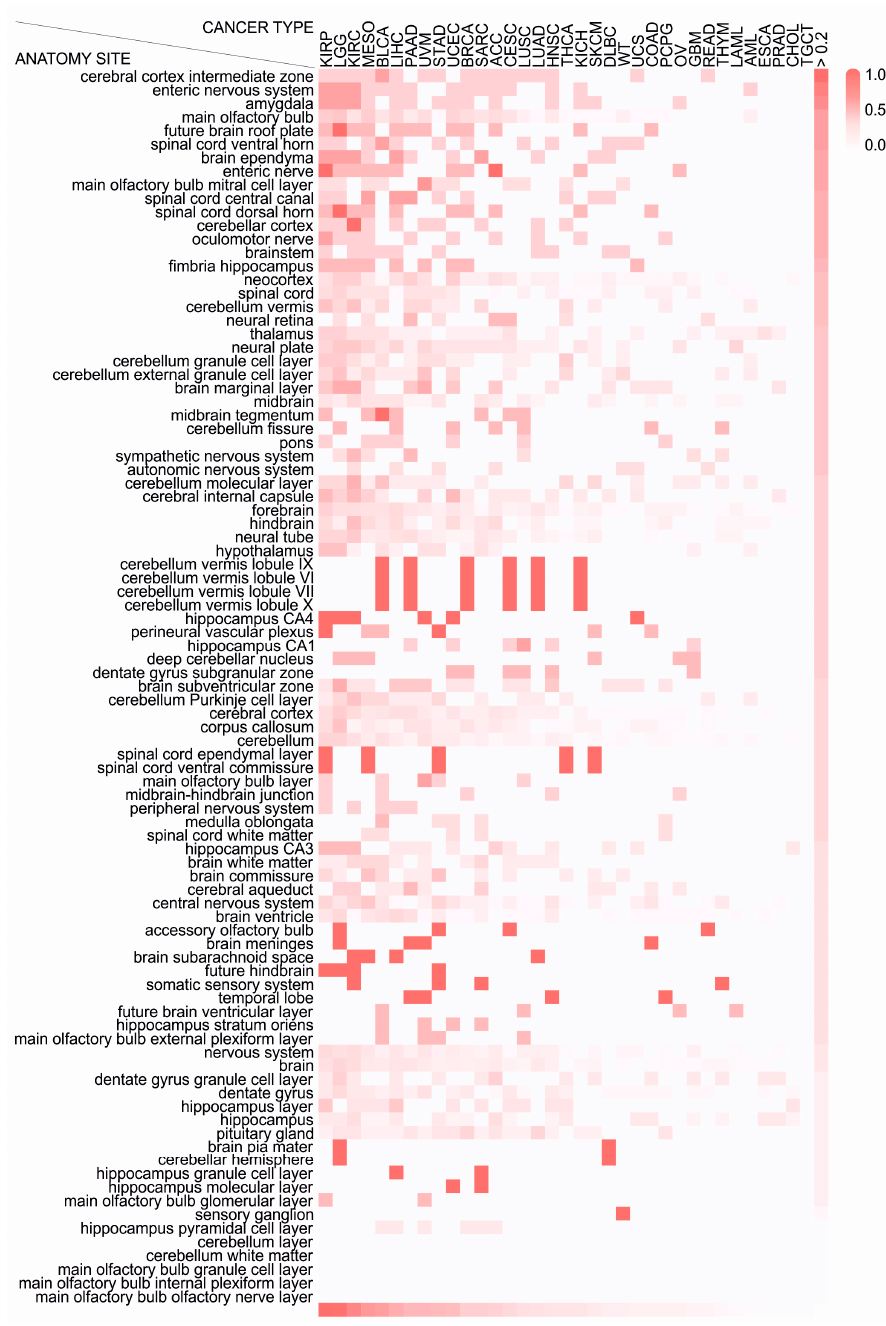
Figure 3. Genes indispensable for the development of distinct anatomical regions of the nervous system are hijacked by specific cancer types. A heatmap of anatomy sites that are enriched for neu.dev and behavioral genes that correlate with poor prognosis per cancer type. The color corresponds to the enrichment of each anatomic site (see